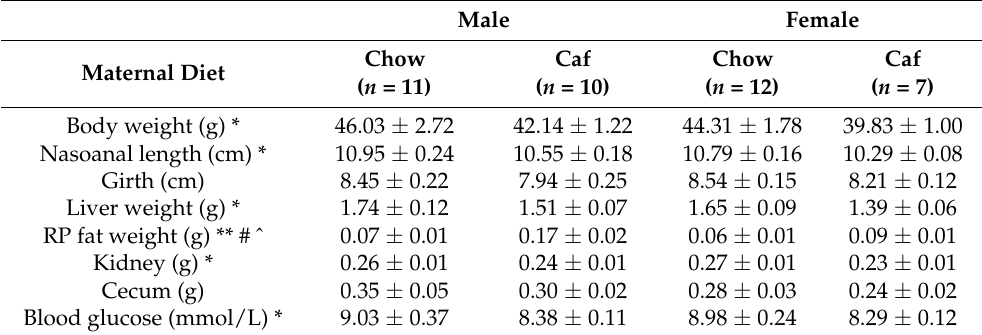
Table 3. Offspring endpoint measurements at PND 20.